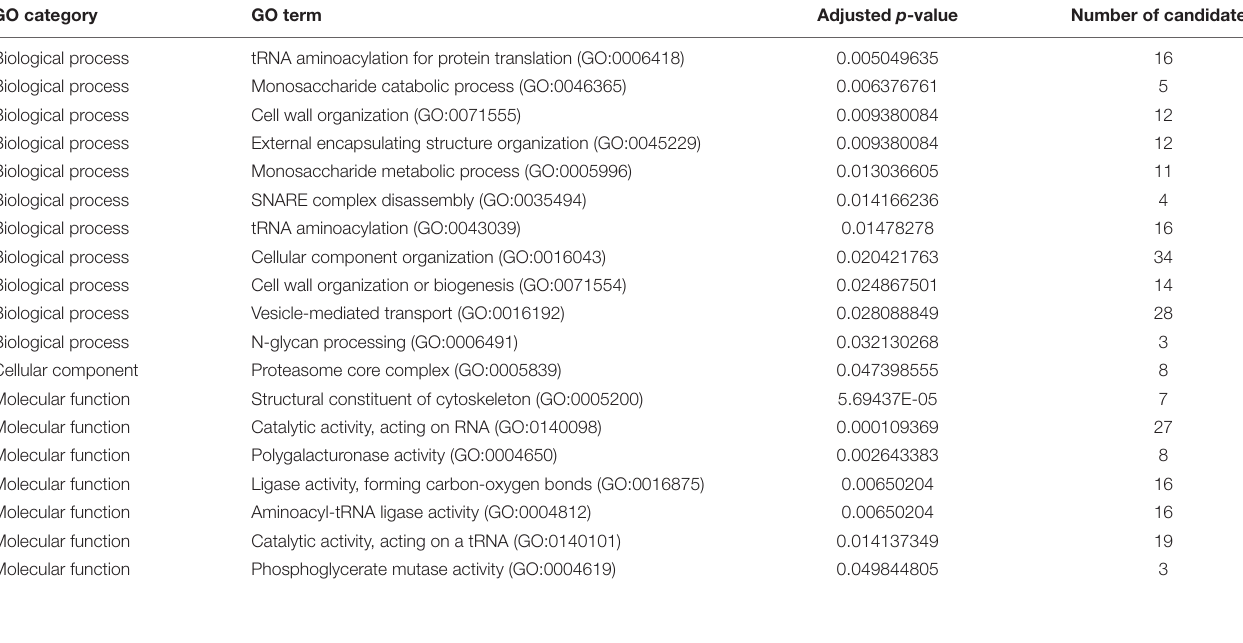
TABLE 1 | GO term enrichment of proteins encoded by genes down-regulated after fungal co-cultivation with P_DAPG for 120 min ( p -value < 0.0001 and Log 2 -fold-change < − 2).